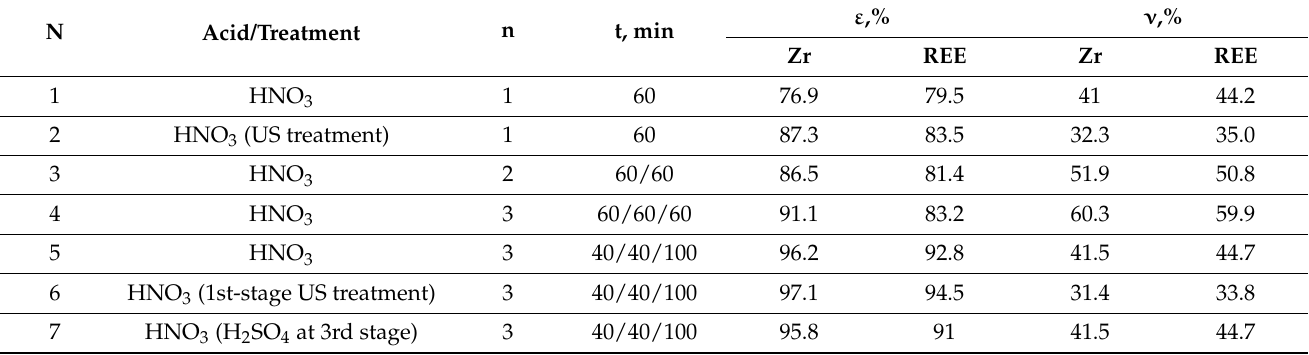
Table 11. Effect of the number and duration of leaching stages on the recovery of valuable